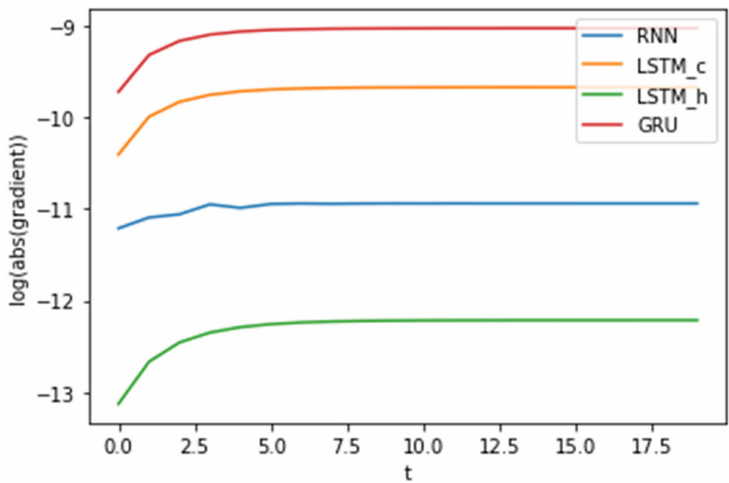
Figure 4. Changes of the derivatives of the three models over time (hour).